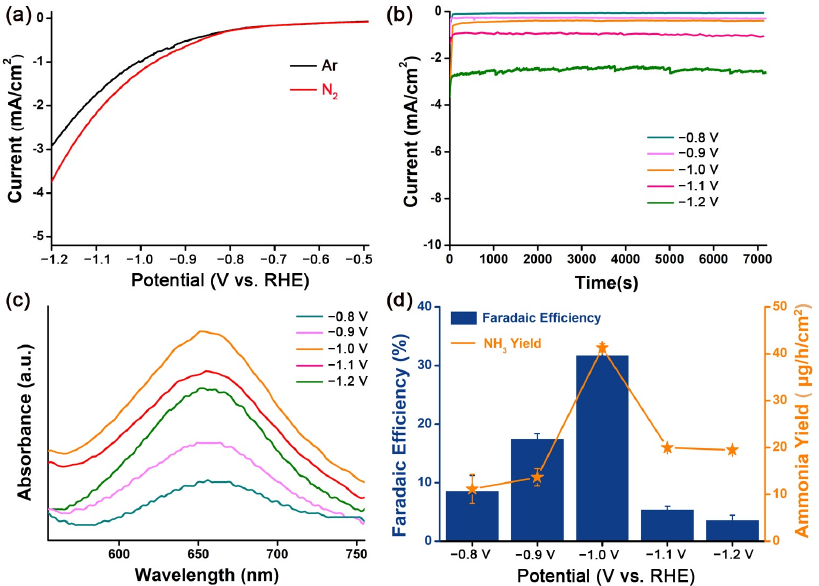
Figure 3. Catalysis performance using the NPS@O-ZIF electrode. ( a ) LSV curves in the N 2 - and Ar- saturated electrolyte. ( b ) CA tests under various potentials and ( c ) the corresponding UV–vis spectra of electrolytes after ENRR is colored with the indophenol indicator. ( d ) Calculation of ammonia yield and Faradaic efficiency.